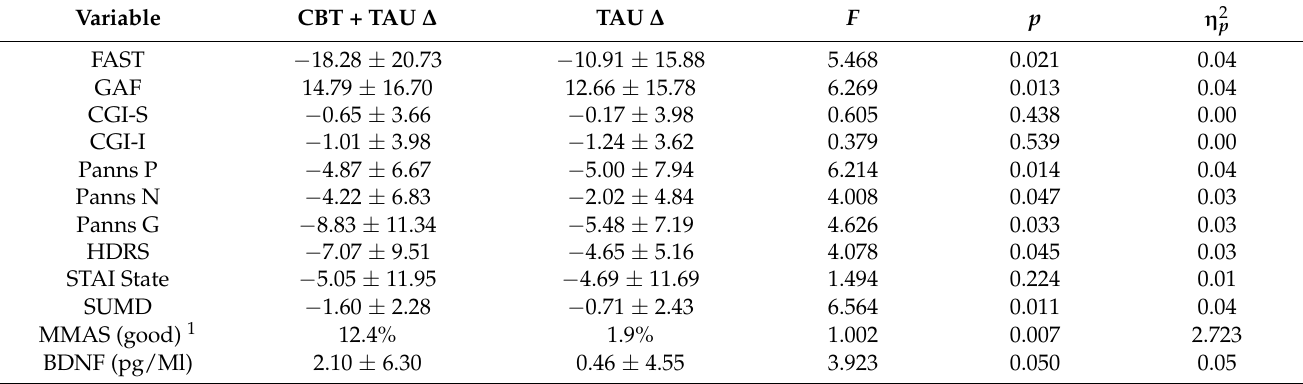
Table 3. A comparison of the course of the disease, adjusting for pre-treatment scores (ANCOVA). Variable CBT + TAU